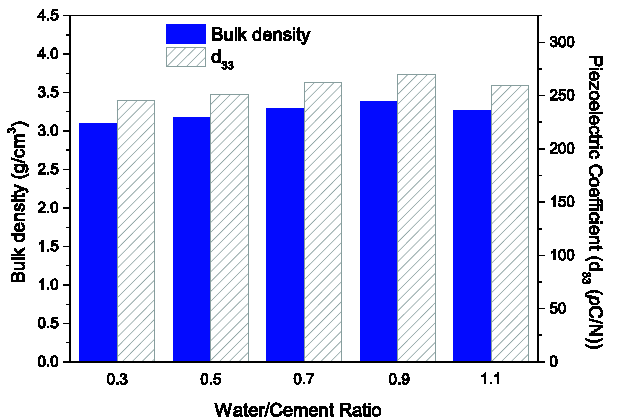
Figure 5. Variation of density and longitudinal piezoelectric coefficient ( d 33 ) of the PZT–PC composites at different water/cement ratios.